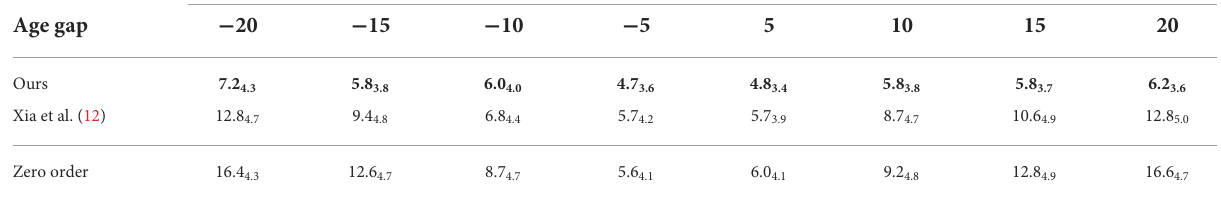
TABLE 1 Mean absolute error (MAE) for age prediction of images generated synthetically from a random testing set of 907 subjects with varied age and grouped in age gaps of 5